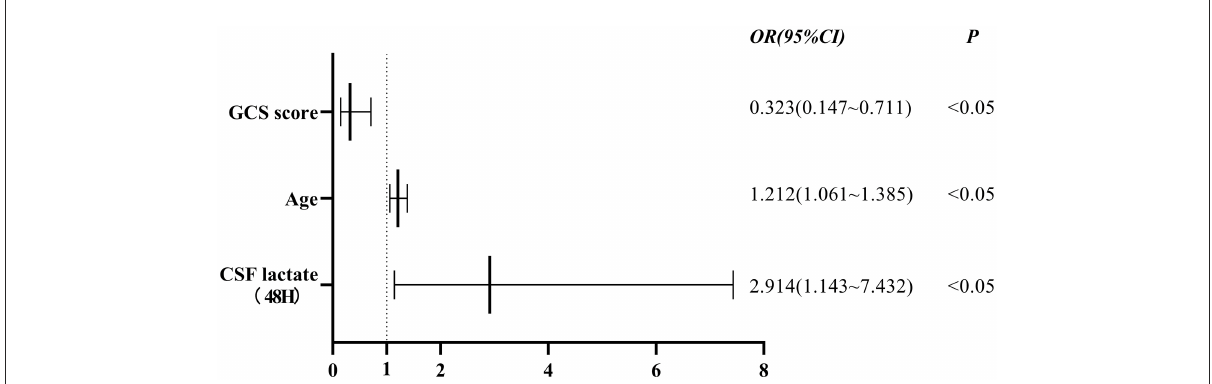
FIGURE3 Association between GCS score, age, CSF lactate levels at 48h after admission and outcomes of patients with TBM. Independent factors associated with the outcomes of TBM patients were GCS score on admission (OR 0.323, 95% CI 0.147–0.711, P < 0.05), age (OR 1.212, 95% CI